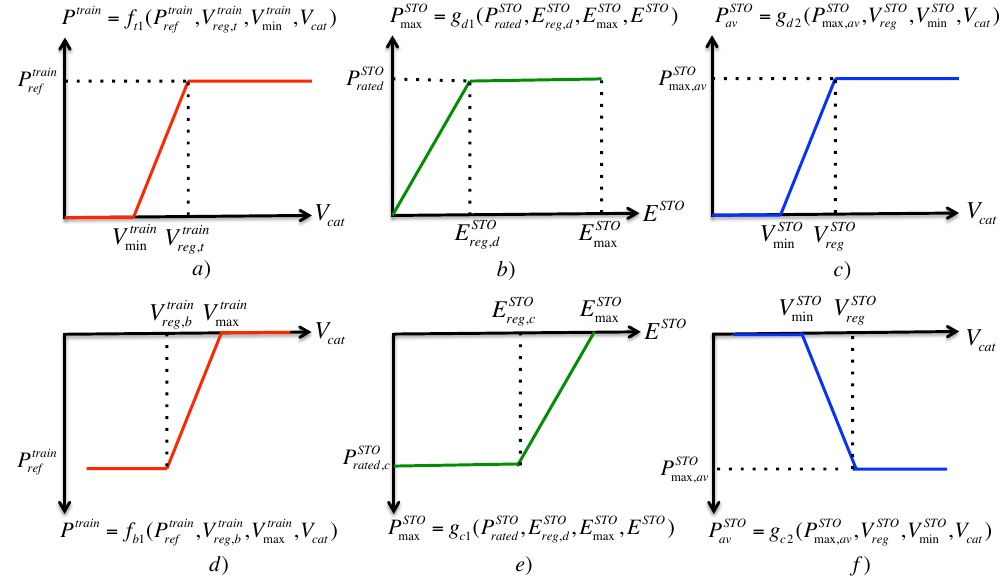
Figure 2. Subfigures ( a – c ) represent the functions that model the behavior of the train and the storage in traction mode. Subfigures ( d – f ) represent the functions that model the behavior of the train and the storage in braking mode. ( a ) Train overcurrent protection in traction mode. ( b ) Maximum power that can be extracted from the storage system in traction mode as a function of the energy level. ( c ) Available discharging power in the storage system as a function of the voltage (overcurrent protection of the storage in traction mode). ( d ) Train squeeze control in braking mode. ( e ) Maximum power that can be injected into the storage system in braking mode as a function of the energy level. ( f ) Available charging power in the storage system as a function of the voltage (overcurrent protection of the storage system in braking